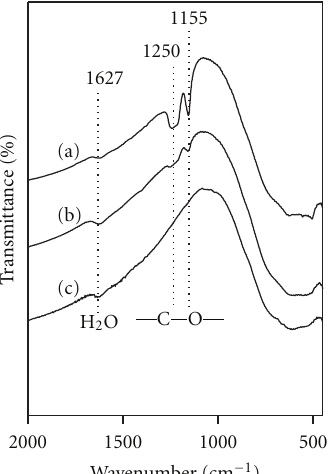
Figure 5: FT-IR spectra for given samples: (a) PureTiO 2 sample after photocatalytic reaction; (b) 1.0-Pt-TiO 2 sample after pho- tocatalytic reaction; (c) PureTiO 2 sample before photocatalytic reaction.